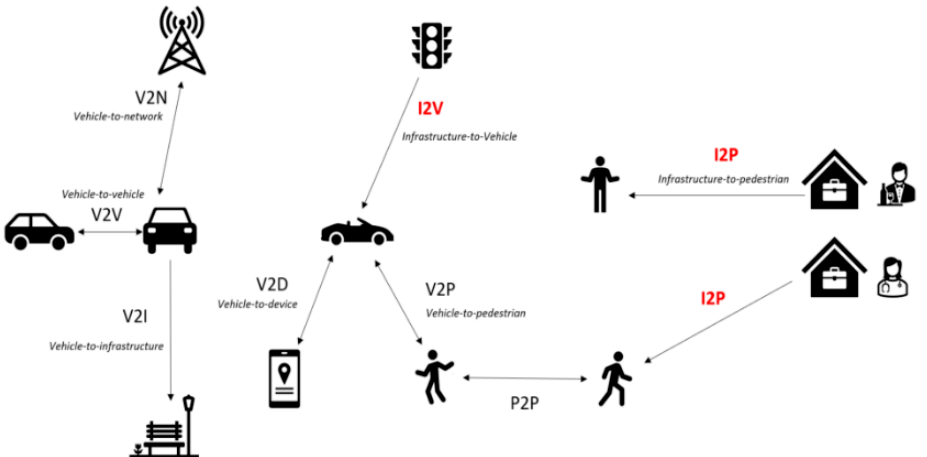
Figure 1. Types of communication in vehicular and Smart City environments; V2N (Vehicle to Network), I2V (Infrastructure to Vehicle), V2V (Vehicle to Vehicle), V2I (Vehicle to Infrastructure), V2D (Vehicle to Device), V2P (Vehicle to Pedestrian), I2P (Infrastructure to Pedestrian).